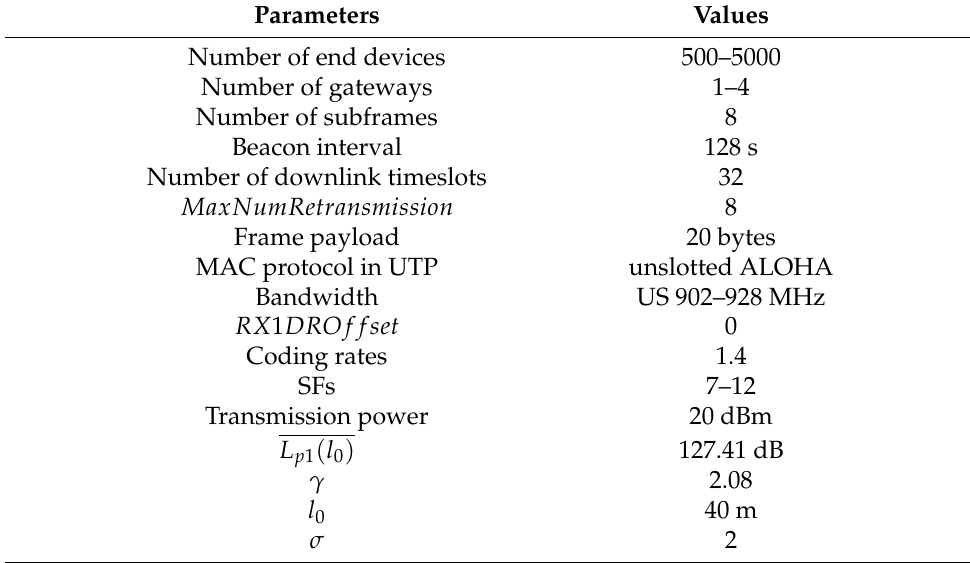
Table 3. Simulation